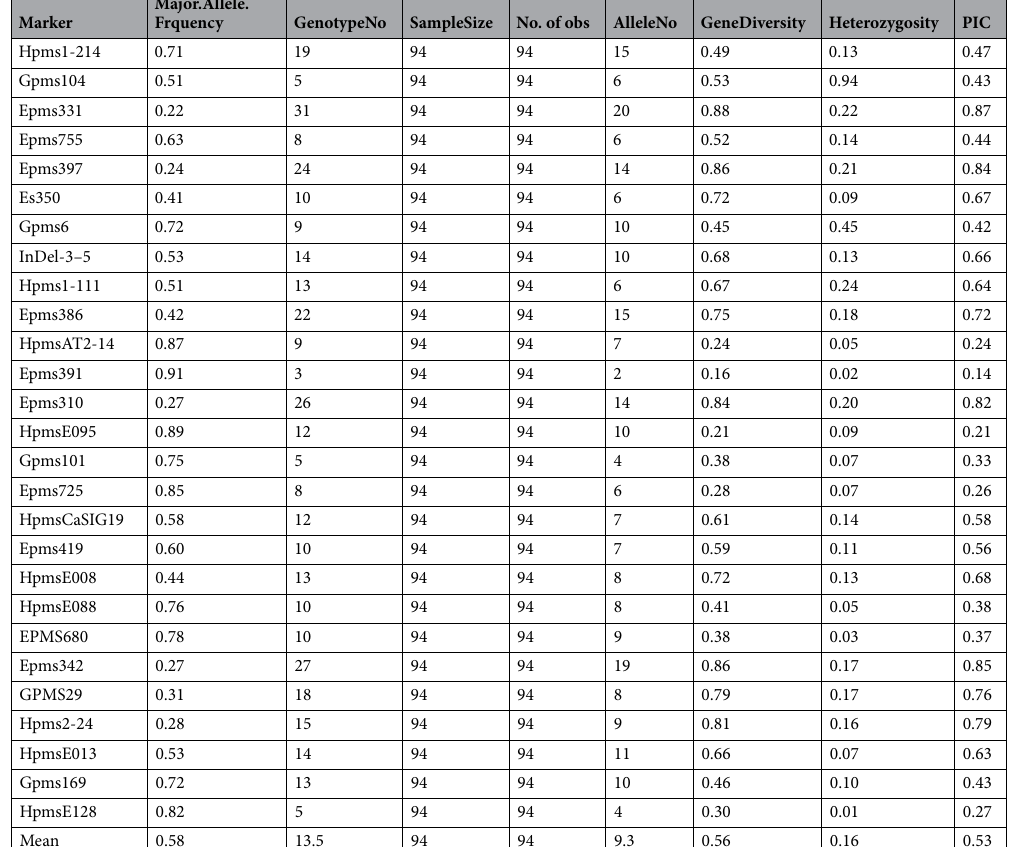
Table 4. Genetic diversity analysis of 94 local landraces at 26 polymorphic simple sequence repeat (SSR) loci and 1 insertion-deletion (InDel)